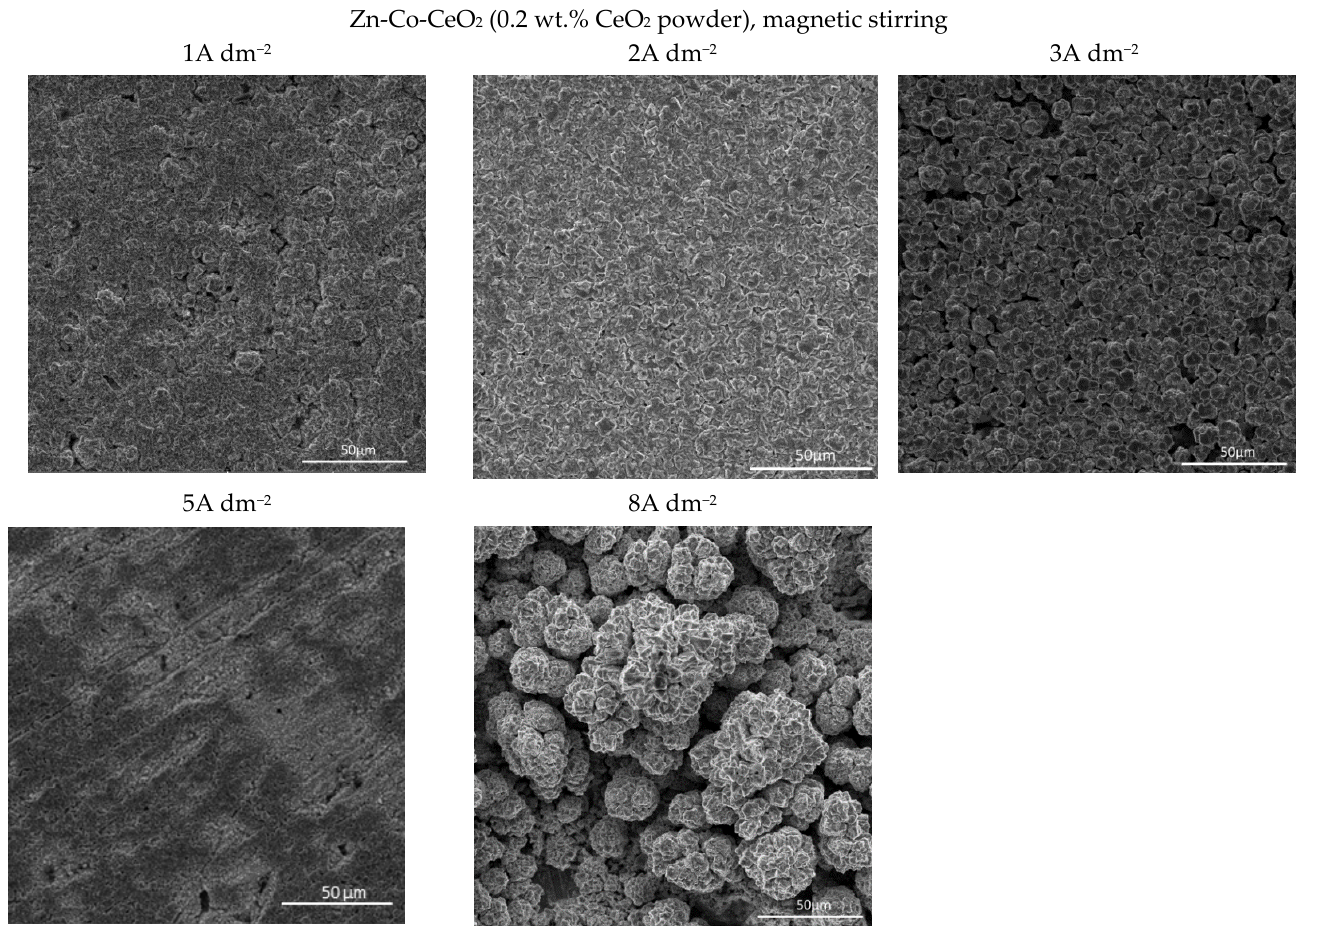
Figure 5. Morphology of the Zn-Co-CeO 2 composite coatings deposited at different current densities from plating solution with 0.2 wt.% ceria powder.